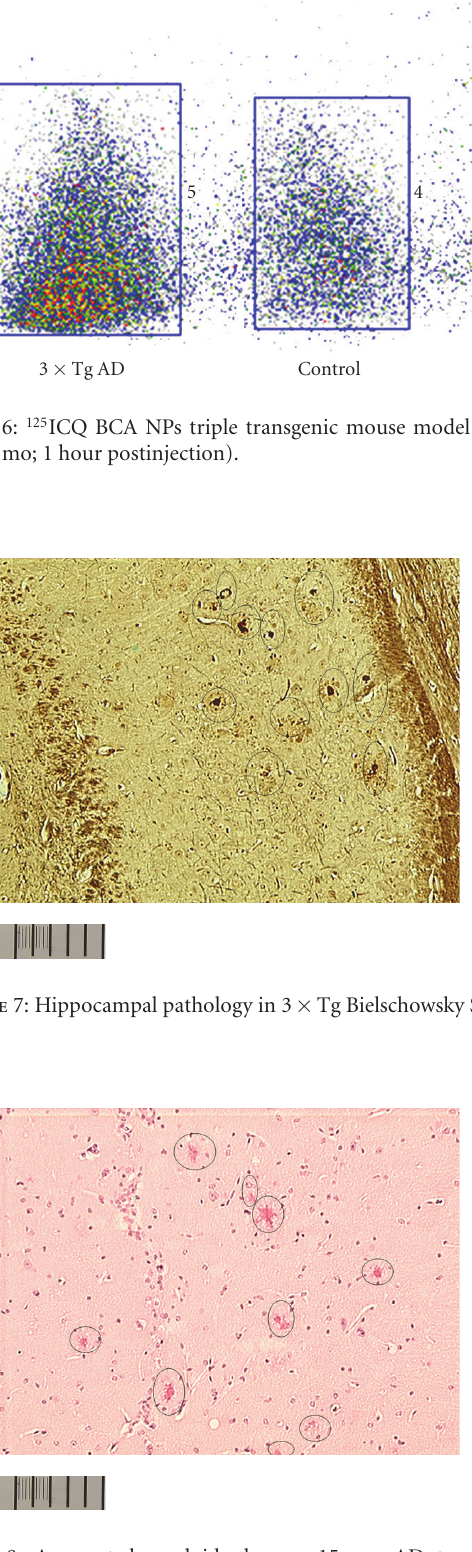
Figure 8: Aggregated amyloid plaques: 15 mo AD transgenic